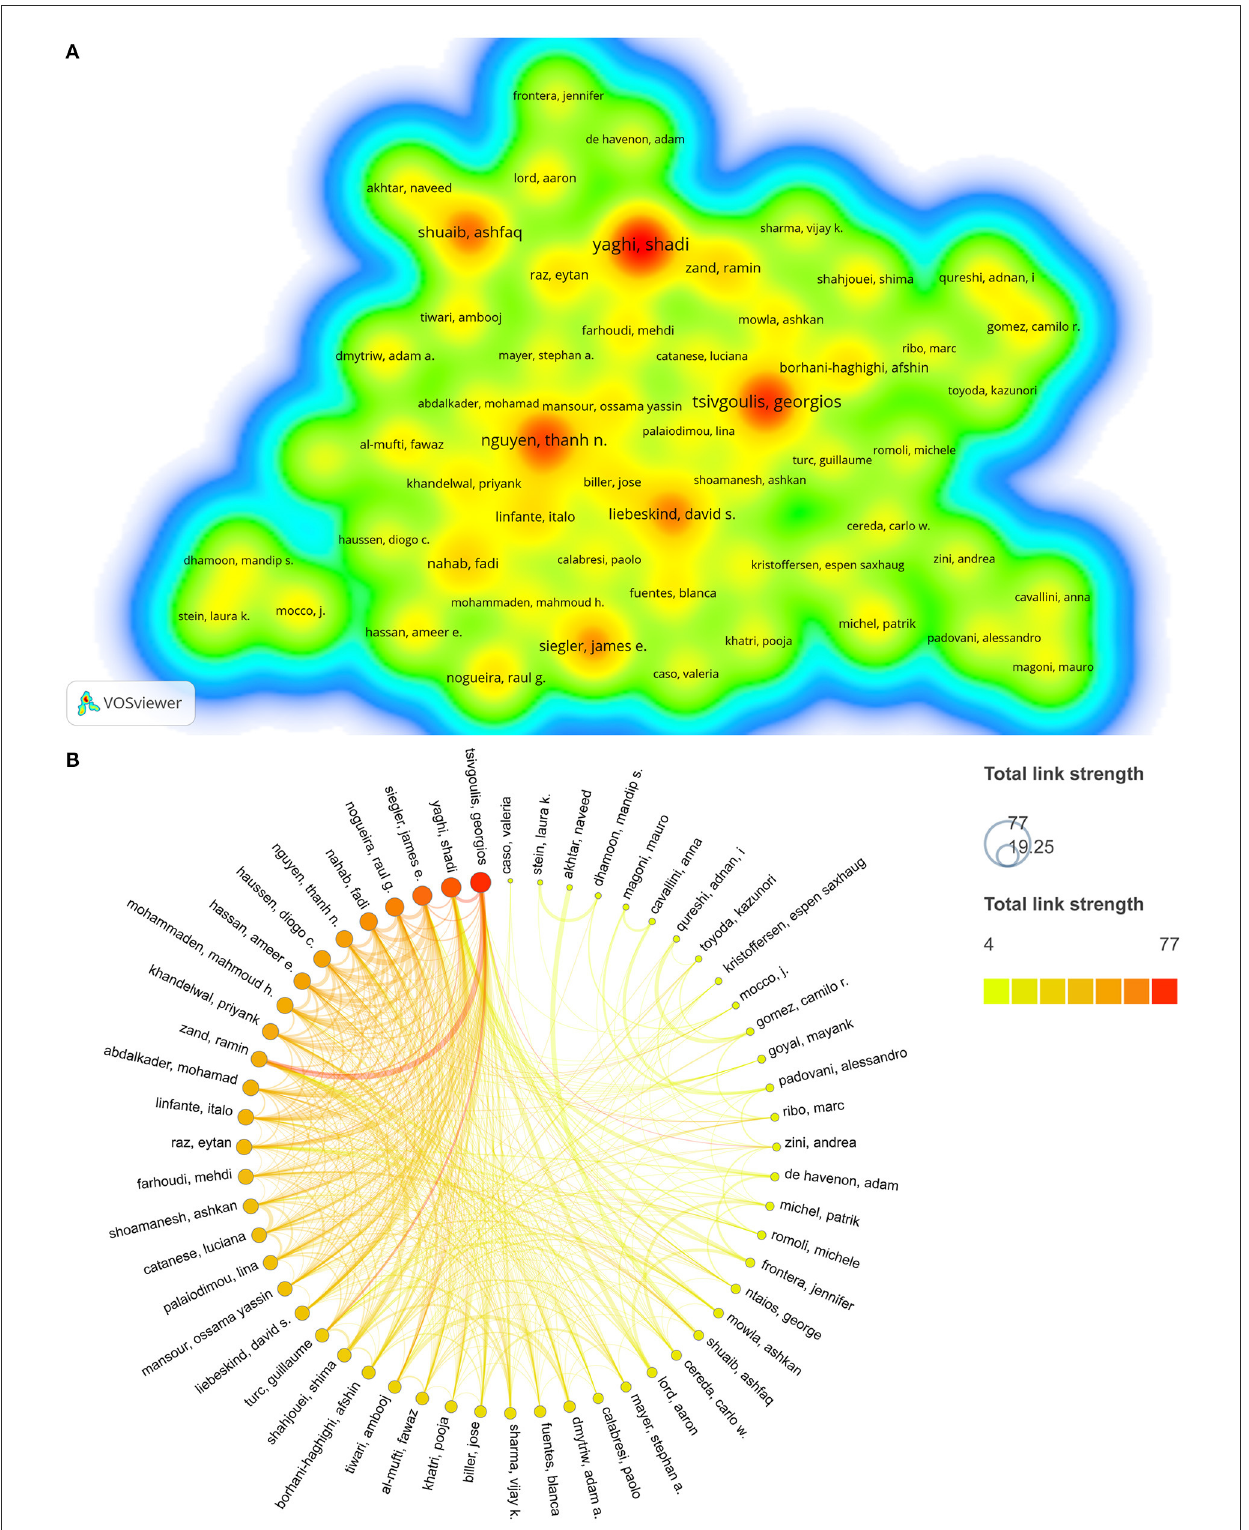
FIGURE3 Author co-authorship networks. (A) Density map of the number of publications by author generated by VOSviewer. Both the color and font size indicates the number of publications of each author. (B) Scimago Graphica-generated chord diagram of author cooperation network. Both the color and size of the nodes indicate the intensity of cooperation between